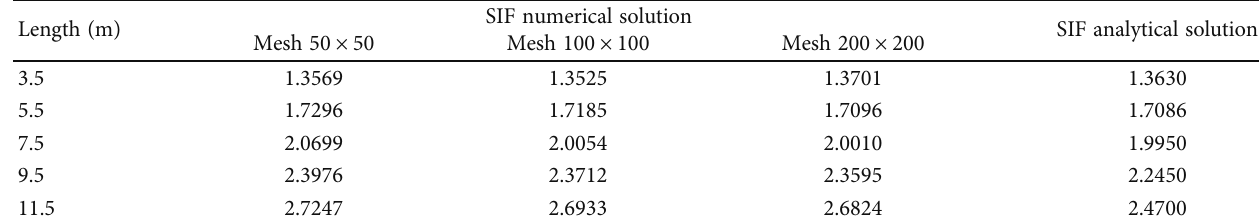
Table 1: Comparison between the SIF values (unit: 10 7 Pa/m 2 ) of the numerical solution with those of the analytical solution for a plate with an edge crack.